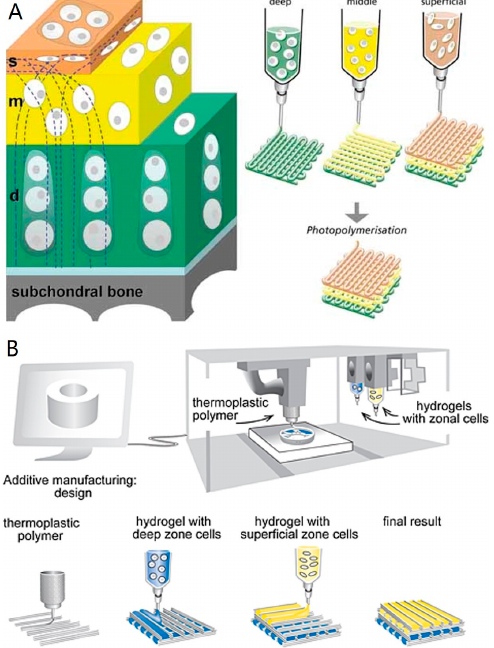
Figure 2. ( A ) Schematic of self-supporting hydrogel bioprinting for fabrication of zonal cartilage constructs. Zonal constructs are printed with chondrocytes from the superficial, middle, and deep zones incorporated in distinct hydrogel precursors in defined geometries. Reproduced with permission. Copy right 2009, Wiley Online Library [144]; ( B ) Schematic of hybrid bioprinting for fabrication of zonal cartilage constructs. Alternating steps of printing polymer and zonal cell-laden hydrogels are performed to obtain zonal constructs Reproduced with permission. Copyright 2015, Wiley Online Library